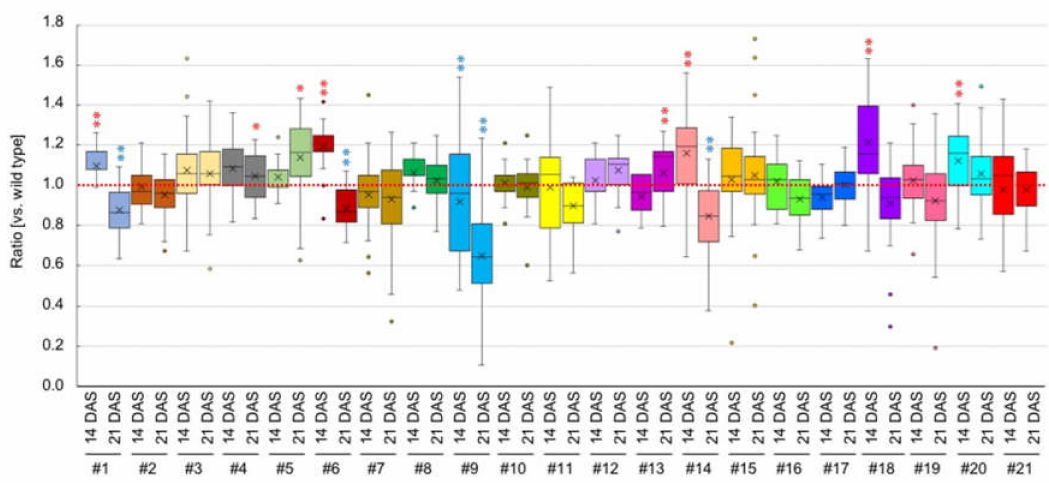
Figure 7. Rosette diameter of overexpressed plants. y-axis shows the ratio of rosette diameter in transgenic plants compared with non-transgenic plants. * p < 0.05, ** p < 0.01 (Student’s t -test). Blue and red asterisks represent decrease and increase plant size,